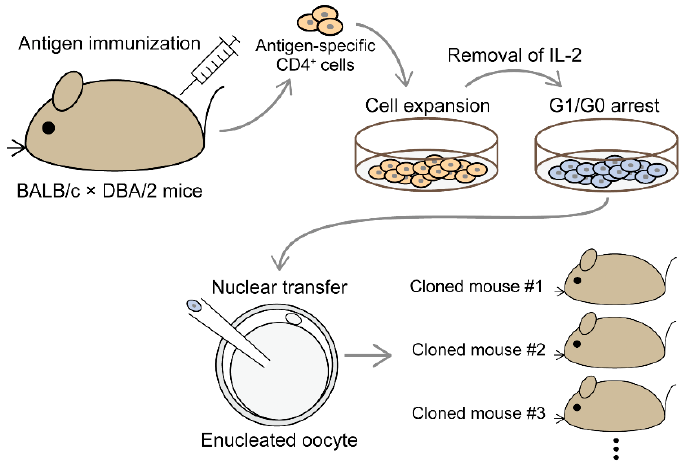
Figure 2. Schematic procedure for generating cloned mice from antigen-specific CD4 + T cells. Antigen-specific CD4 + T cells obtained from immunized BALB / c × DBA / 2 mice were expanded by antigen stimulation culture in vitro. Upon removal of IL-2, G1 / G0 phase-synchronized cells were used for somatic cell nuclear transfer. Various lines of cloned mice were obtained.